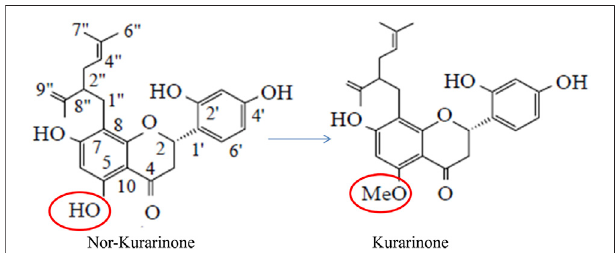
FIGURE 1 | Structural difference between nor-kurarinone and